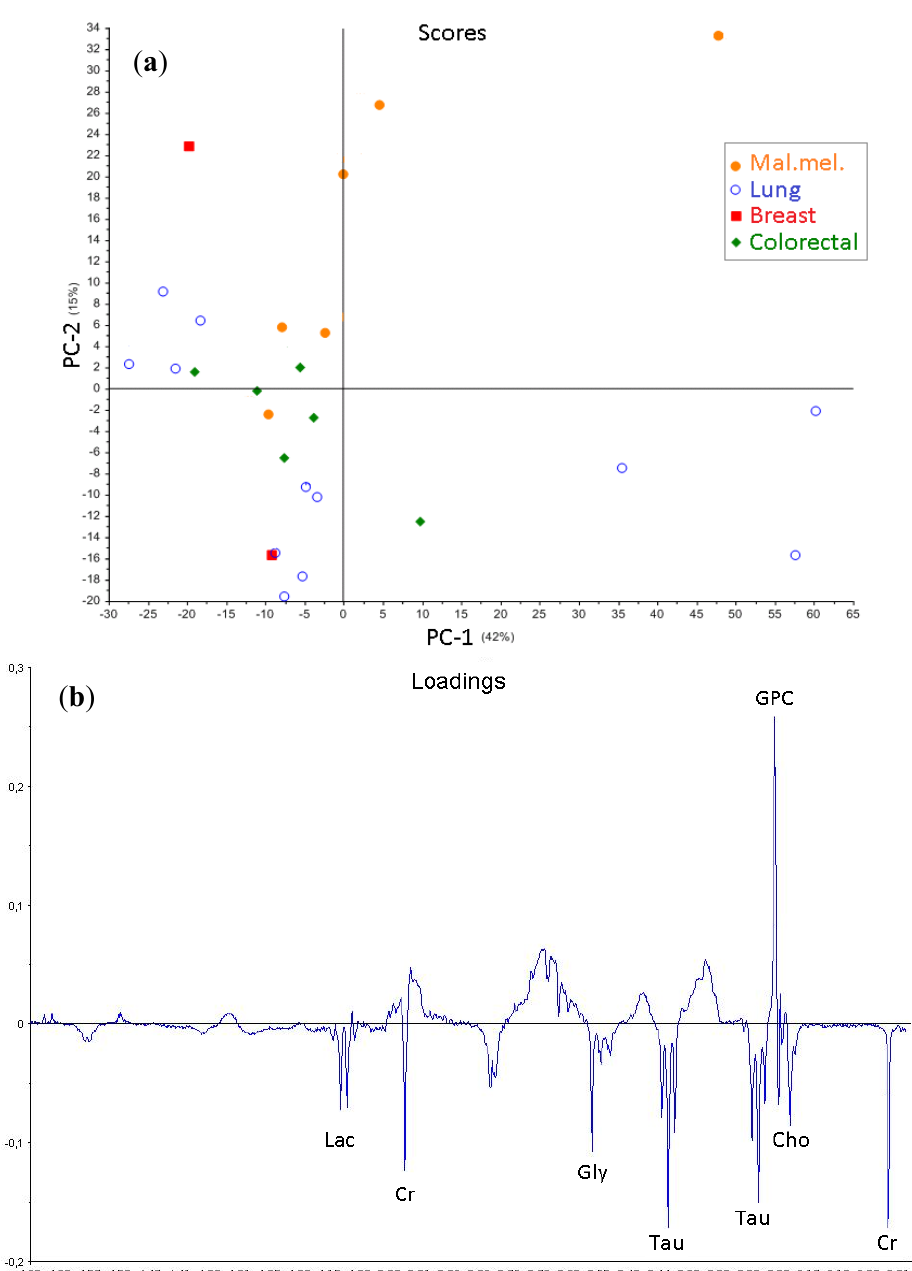
(ppm region 4.68–2.98) from brain metastases with less than 50% necrotic tissue ( n = 26); ( b ) The loading plot of PC-2 indicates the metabolites GPC, Cr, Tau, Gly, Cho and Lac